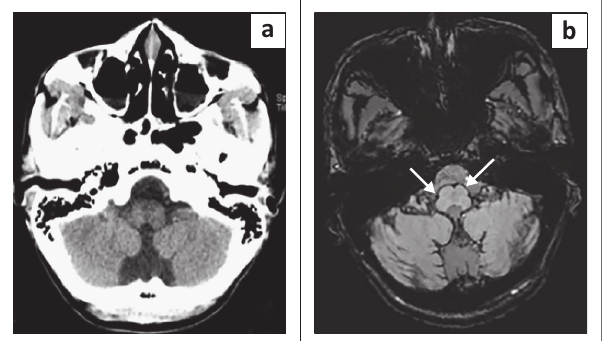
FIGURE 5: The NECT (a) and SWI (b) in a ruptured right MCA aneurysm. SWI at 3 months demonstrates haemosiderin staining (white arrows) on the pial surface, not seen on initial